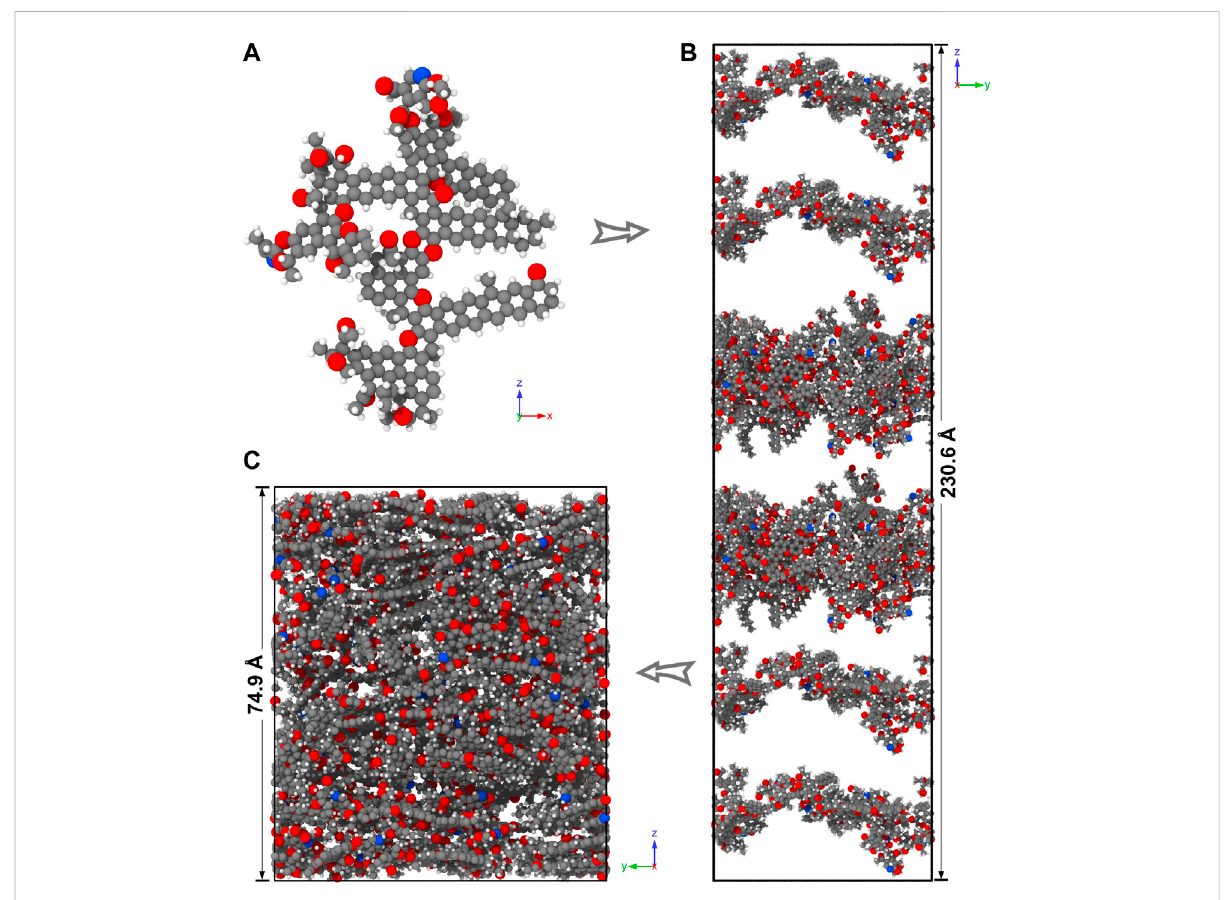
Construction procedure of the sandwich system for the shear friction simulation. (The gray refers to carbon atoms, the red refers to oxygen atoms,thebluereferstonitrogenatoms,andthewhitereferstohydrogenatoms.) (A) Conformationoftheprimarystructurecoal, (B) initialsandwich coal friction system, and (C) optimized coal friction